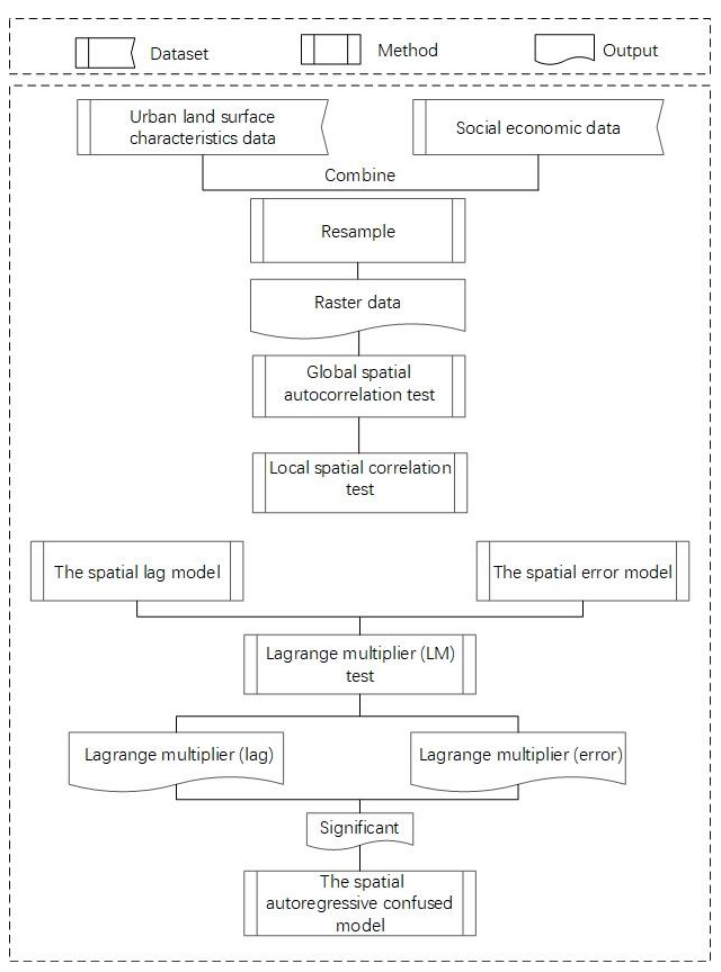
Figure 5. Flowchart of the